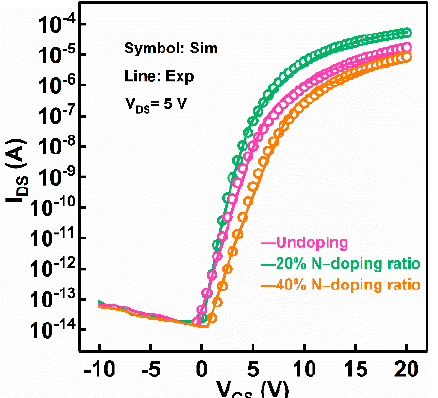
Figure 2. Simulated transfer characteristics for a-IGZO TFTs with different N-doping conditions: undoped, 20% N-doping ratio, and 40% N-doping ratio.